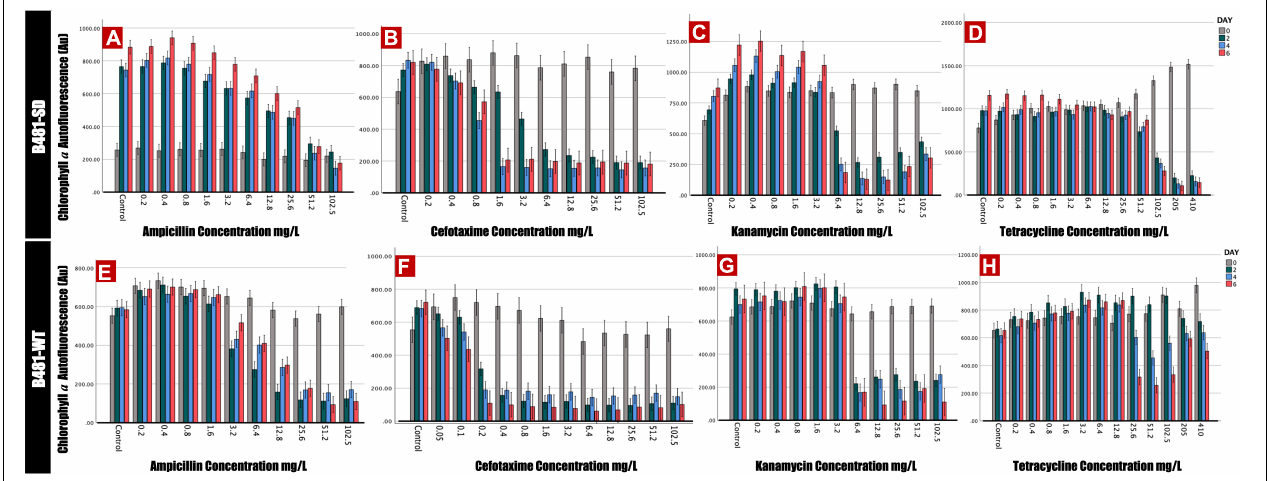
FIGURE 2 | Chlorophyll a autofluorescence of Fremyella diplosiphon strains B481-SD and B481-WT reflected by excitation of 420 nm and emission of 680 nm. B481-SD strain was exposed to ampicillin, cefotaxime, kanamycin, and tetracycline concentrations ranging from 0.2 to 102.5 mg/L (A–D) , B481-WT strain was exposed to ampicillin and kanamycin concentrations ranging from 0.2 to 102.5 mg/L; 0.05–102.5 mg/L for cefotaxime and 0.2–410 mg/L for tetracycline (E–H) . Both strains are cultivated with four antibiotics for 6 days at 28 ◦ C with a light intensity of 30 µ mol m − 2 s − 1 . Mean and standard deviations are indicated by error bars.